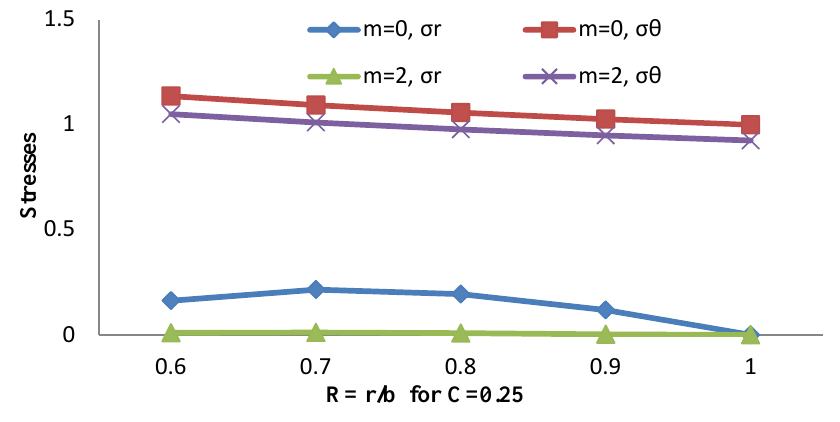
Figure3. Stresses distribution with respect to radii ratio R = r/b for C = 0.25.